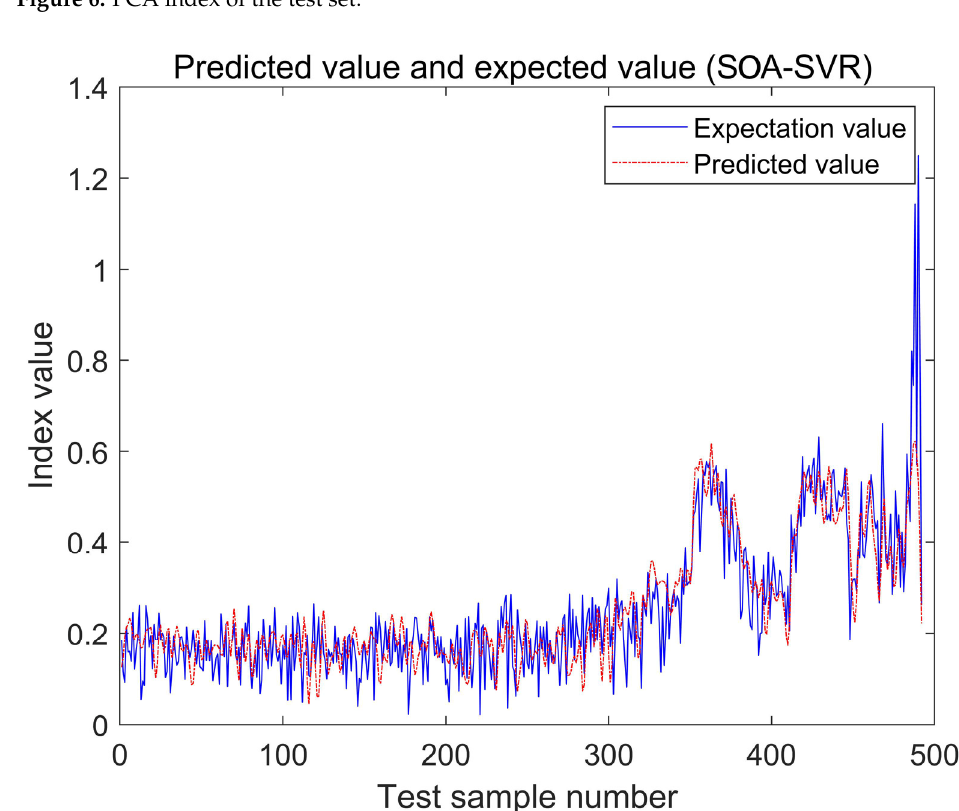
Figure 7. The regression prediction analysis of the test